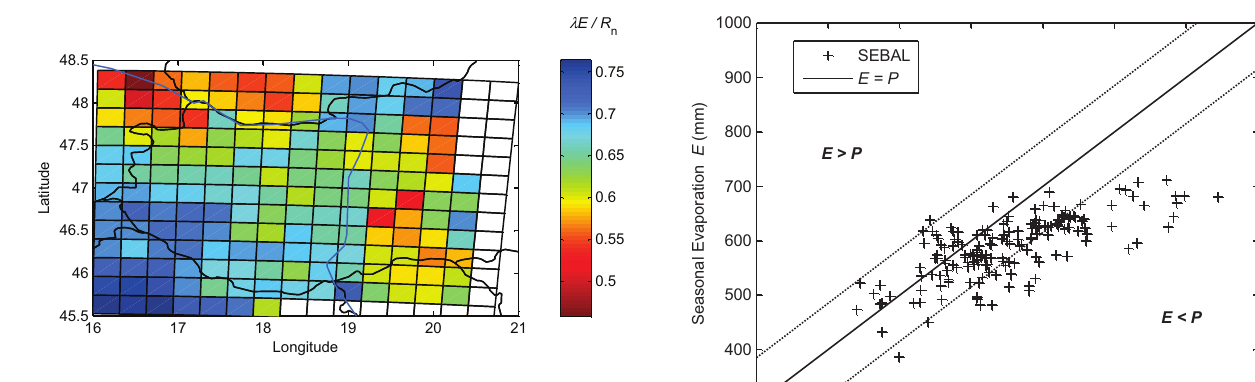
Fig. 5. Map of seasonally averaged λE/R n for the Transdanubian test region in 2005. λE / R n has been derived from satellite images using SEBAL. The spatial resolution is 0.25 ◦ . The season extends over 30 weeks, starting in week 13. Fig. 6. Seasonal SEBAL derived evaporation E (mm) over a 30